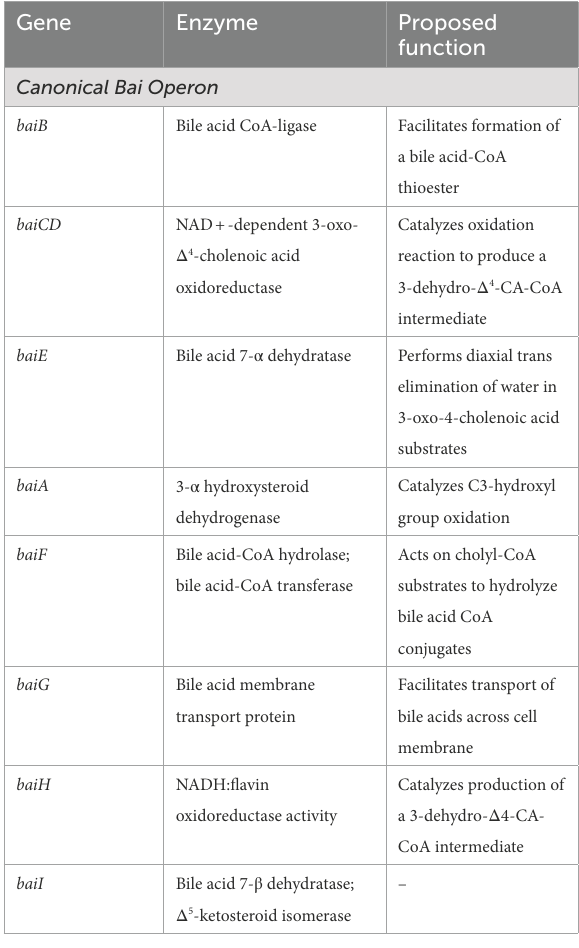
TABLE 1 Canonical bai operon genes and their encoded